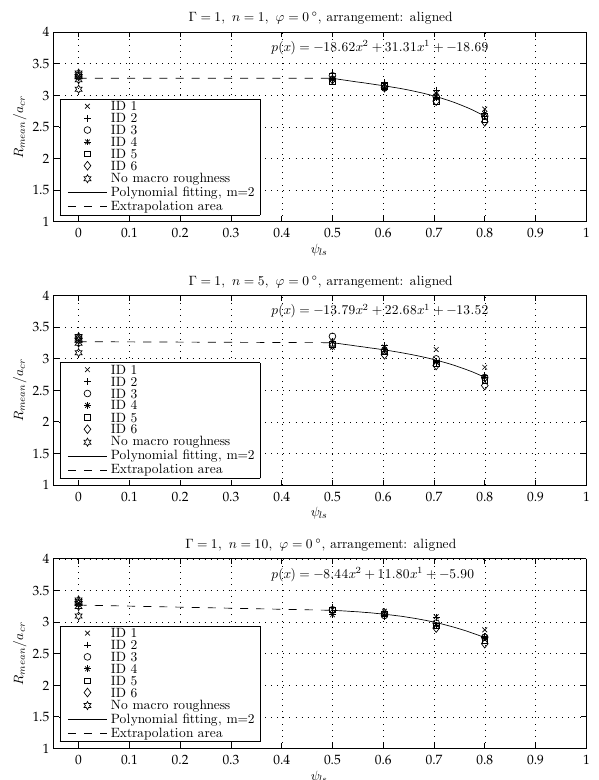
Fig. 10. The relative wave run-up ( R mean ) as a function of the long- shore obstruction ratio ( ψ cs ), 0 = 1. The experimental data are fit- ted to a polynomial of degree m = 2 and the equations are given according to the investigated number of MR rows n = 1 , 5 ,